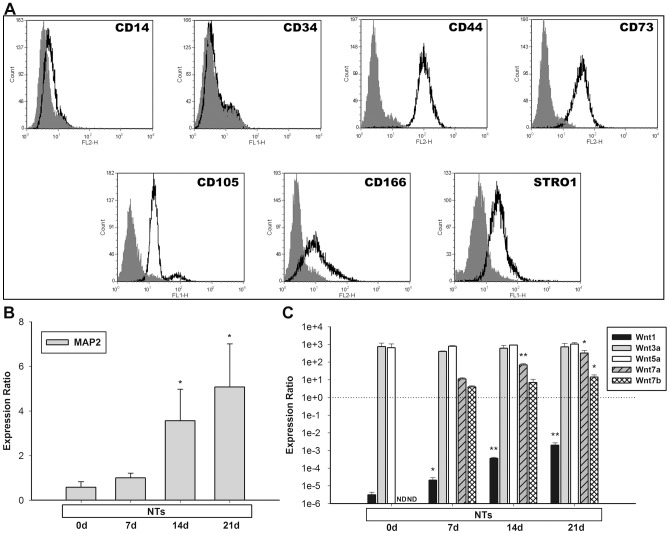
Flow cytometric analysis and Wnt profiles of hMSCs by the induction of NTs.(A) Bone marrow-derived hMSCs were analyzed following four cell passages. hMSCs were positive for CD44, CD73, CD105, CD166, and Stro-1, and negative for CD14 and CD34. The solid curves indicate each type of antibody, and the filled curves indicate mouse IgG as the negative control. (B) mRNA levels of MAP2 were quantified on days 7, 14, and 21 during stimulation with NTs. NTs significantly increased MAP2 levels on days 14 and 21. Untreated hMSCs served as the control. (C) mRNA levels of Wnt1, Wnt3a, Wnt5a, Wnt7a, and Wnt7b were quantified on days 7, 14, and 21 during stimulation with NTs. NTs increased the expression of Wnt1 and induced expressions of Wnt7a and Wnt7b. * p<0.05, ** p<0.01 (i.e., treated vs. control in the Wnt1, Wnt3a, and Wnt5a groups; NTs at 14 and 21 days vs. NTs at 7 days in the Wnt7a and Wnt7b groups). Data are presented as the mean ± SD of one triplicate experiment that was representative of three independent experiments. * p<0.05, ** p<0.01 (i.e., treated vs. control). ND, not determined.